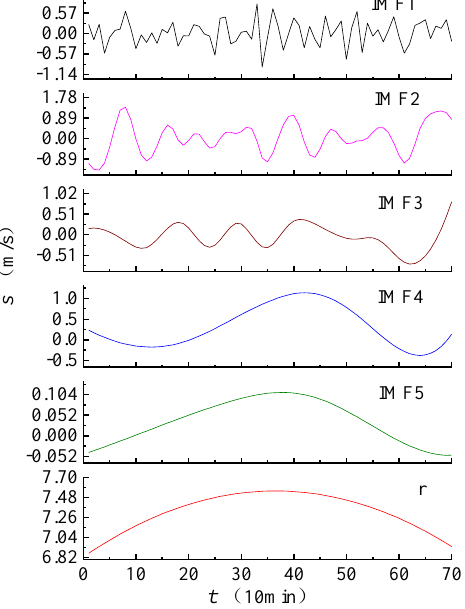
Figure 9. EVMD results of the first 70 points in the wind speed series.